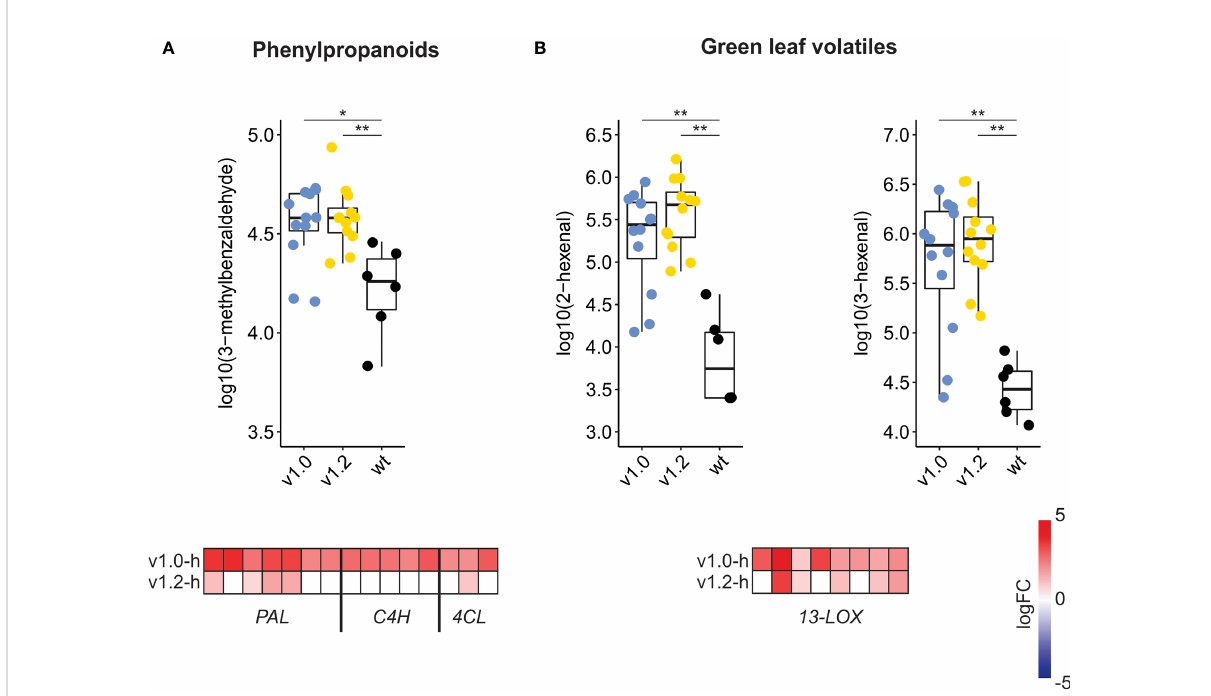
FIGURE 4 Secondary metabolism changes in SxP on the volatilome and transcriptome levels. (A) Abundance of phenylpropanoid-derived 3- methylbenzaldehyde in wt and high-producing SxP and logFC values of phenylpropanoid-related genes ( PAL , C4H , 4CL ), as compared to wt plants. (B) Abundance of green leaf volatiles 3- and 2-hexenal in wt and high-producing SxP and logFC values of 13-LOX genes as compared to wt plants. For volatile compound abundance, ** denotes p < 0.01 and * denotes p < 0.05. Raw data on abundance of volatile compounds were taken from Mateos-Ferna ́ ndez et al. (2021), and analysed data for all metabolites are available in Supplementary Table S3; this fi gure presents only three selected examples of analysed volatiles. Boxplots are shown only for adult samples of v1.0 and v1.2 plants, as described in Mateos- Ferna ́ ndez et al. (2021). Colour saturation denotes logFC values, as given on the scale. Only genes with adjusted p-value < 0.05 are shown. For the full list of depicted genes, see Supplementary Table